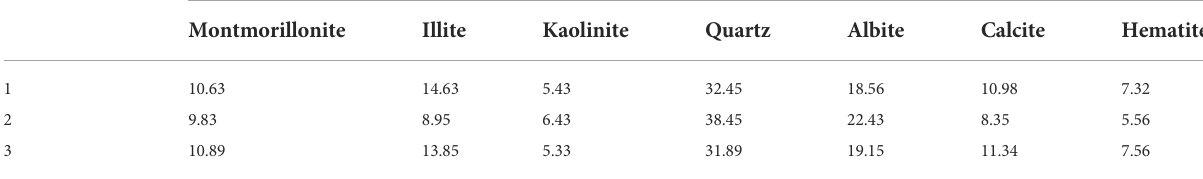
TABLE 2 Mineral composition and quantitative